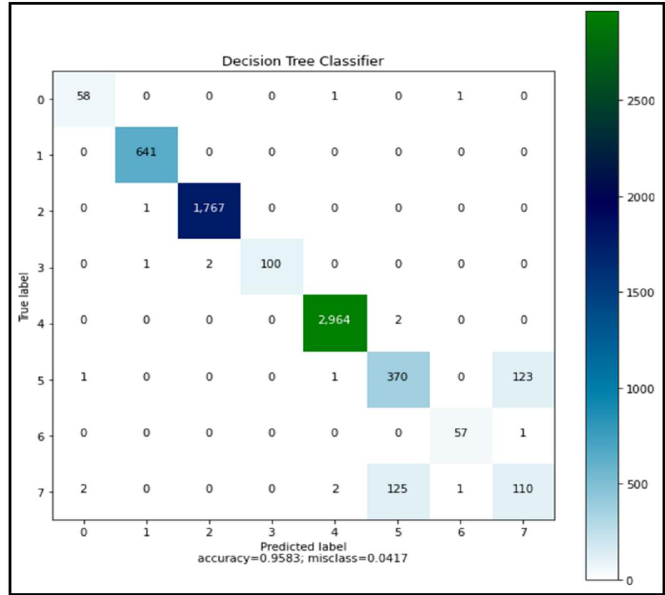
Figure 10. Confusion matrix for decision tree.